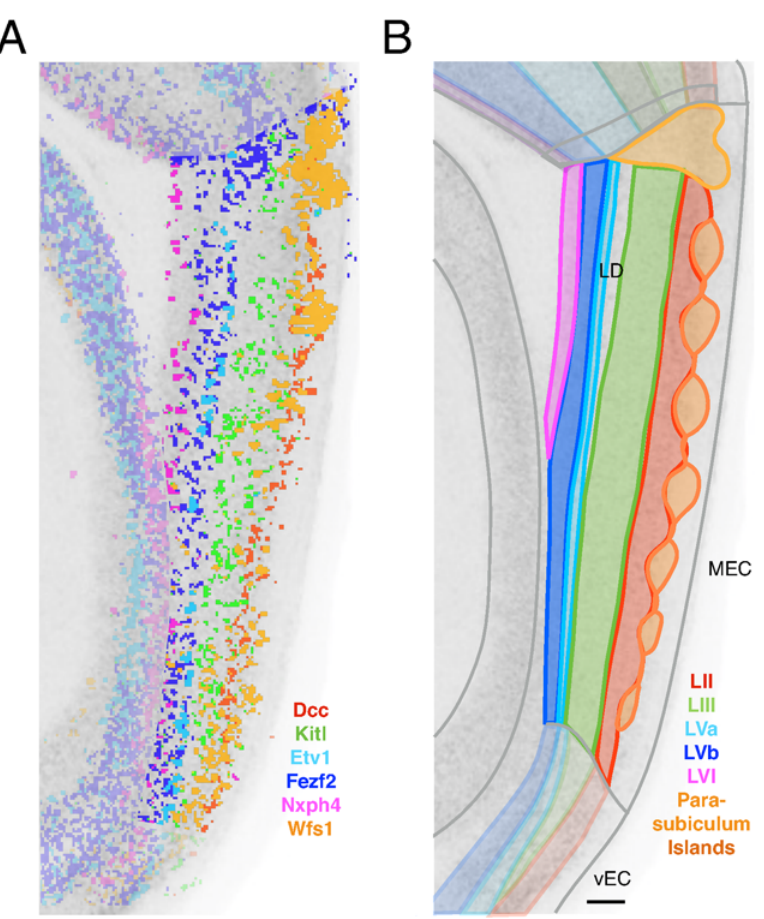
Figure 4. Laminar and intralaminar organization of MEC defined by differential gene expression. (A) Composite image shows high-intensity pixels for 6 exemplar genes with layer-specific expression. Pixels outside of the MEC and parasubicular region are made semitransparent. Images for the genes Dcc and Wfs1 were re-registered for a second time after manual pre-processing to improve the quality of registration for this figure. (B) Schematic showing a refined genomic atlas of the layers and borders of MEC. The region between layer III and V is the lamina dissecans (LD).